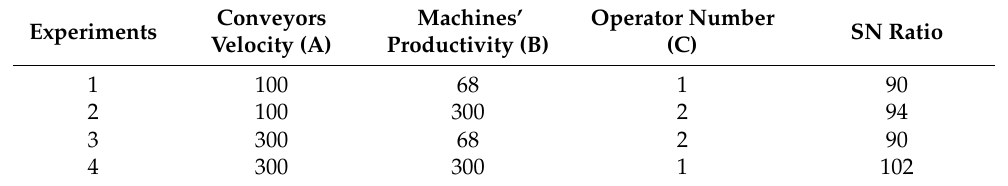
Table 12. Resulting L4 Array for the Use Case.